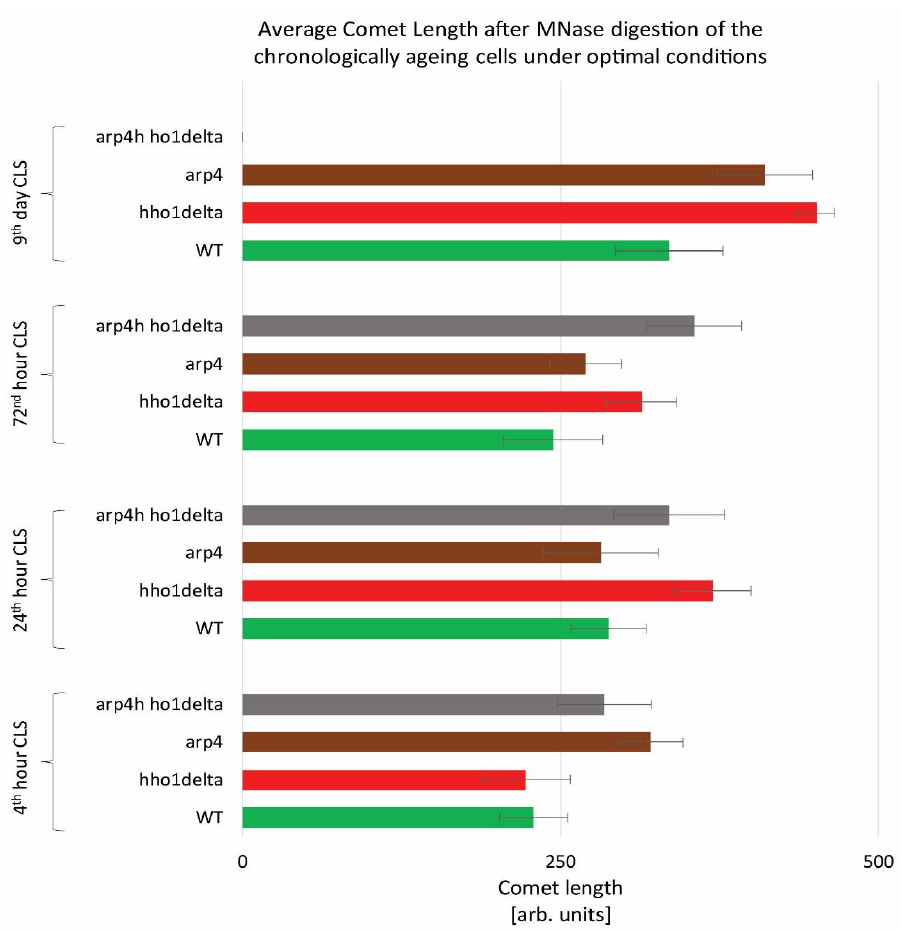
Figure 2. Higher-order chromatin loop dynamics of WT, hho1delta , arp4, and arp4 hho1delta yeast cells cultured for a period of nine days under optimal conditions assessed by ChYCA. Three repetitions of the experiment were done and results are presented as MEAN of the comet length values in (arb. units) ± STDV.